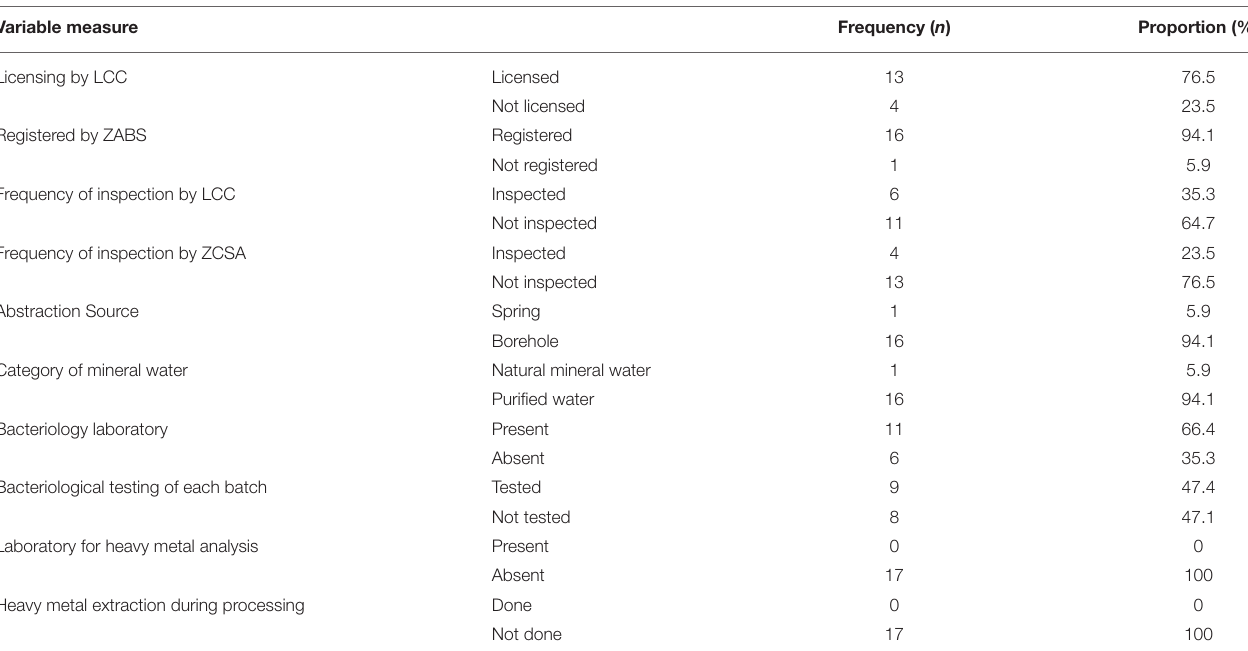
TABLE 1 | Descriptive characteristics of companies that produce packaged water in